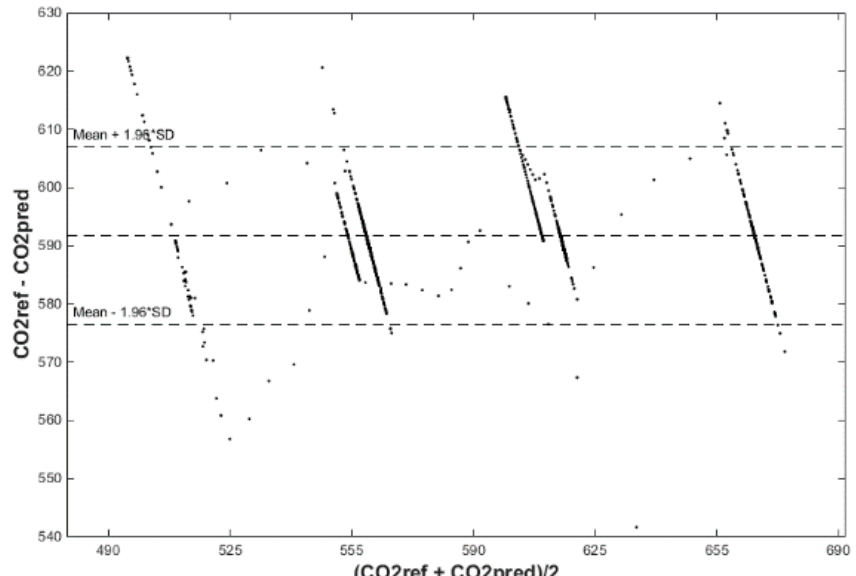
Figure 31. Bland–Altman for the reference and predicted CO 2 waveforms (SRLMS AF) from 27 June 2018 in R104 with an ANN with 60 neurons and SCG method trained with data from 25 June 2018 in R203. Table 7. Learned ANN SCG from 25 June 2018 in R203 (with T in, rH in and an FBG sensor for PPM) and prediction with cross-validation for 26 June 2018 in R104 (with T in, rH in and an FBG sensor for PPM), 27 June 2018 in R104 (with T in, rH in and an FBG sensor for PPM), 28 June 2018 in R104 (with T in, rH in and an FBG sensor for PPM).